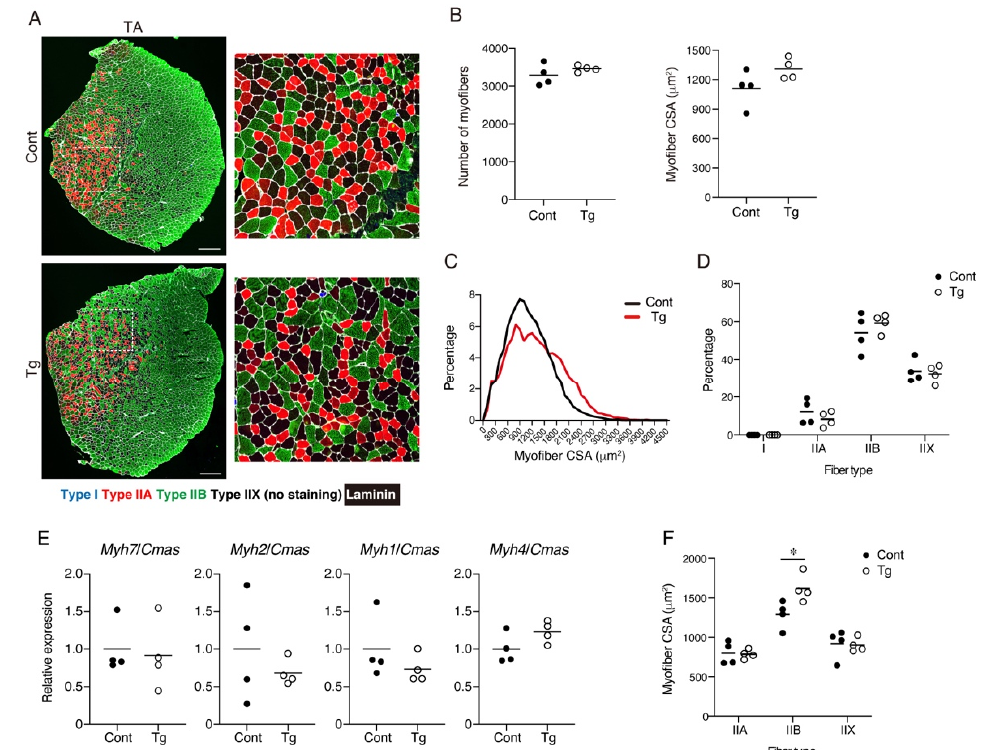
Figure 2. An analysis for the number, cross-sectional areas, and subtypes of the myofibers. ( A ) Tibialis anterior (TA) muscle sections of the Tg mice and littermate control mice (Cont, WT / CAG-CAT-Bmp3b ) were stained with antibodies against MyHC I (blue), MyHC IIA (red), MyHC IIB (green), and laminin (white). The right panels are magnified views of the boxed regions in the left panels. ( B ) The number and cross-sectional areas (CSA) of the myofibers are shown. ( C ) The CSA distribution is displayed by a histogram. Note that the myofibers of the Tg mice are distributed in the larger region, while those of the control mice are distributed in the smaller region. ( D ) The percentage of each fiber type is shown. ( E ) The gene expression levels for Myh7 (type I), Myh2 (type IIA), Myh1 (type IIX), and Myh4 (type IIB) are shown. ( F ) The CSA of each fiber type was measured. The data are expressed as the means and individual data points; two-sided unpaired t -test. n = 4 mice per genotype. * p < 0.05. Scale bar: 300 µ m ( A ).